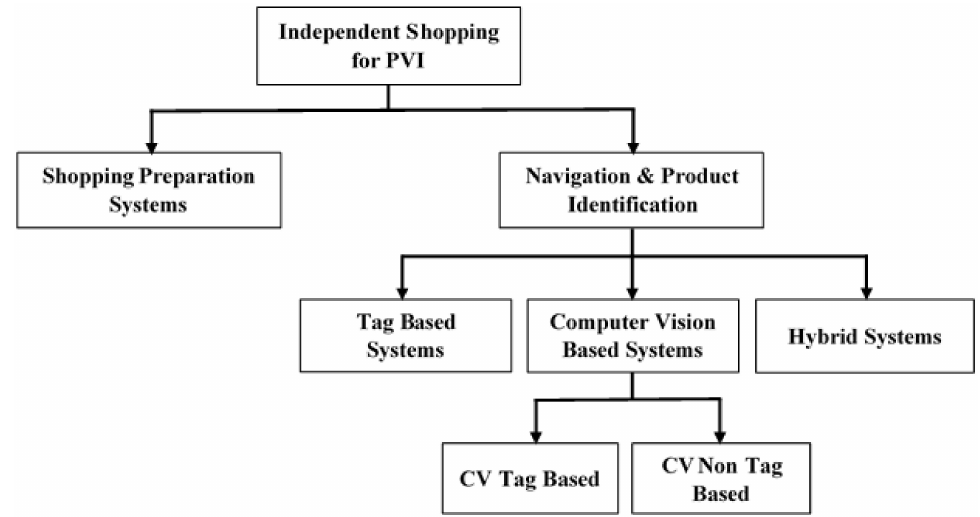
Figure 2. MAT solutions for the parts of the shopping process for